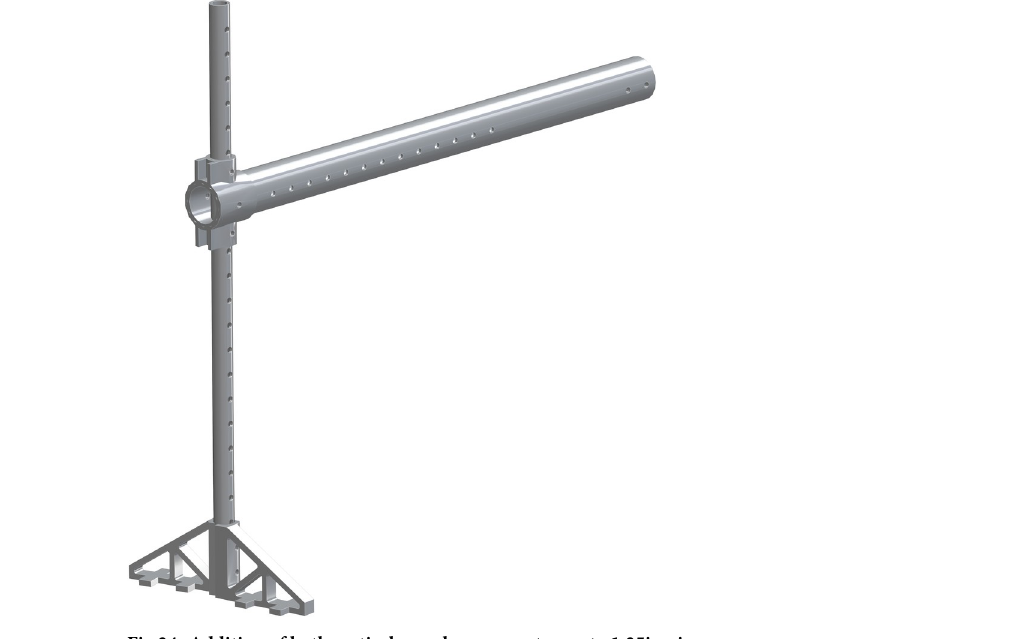
Fig 24. Addition of both vertical_pvc_leg_support_new to 1.25in pipe. a. The foot holder can angle 90 degrees to the left and to the right up the upright position.